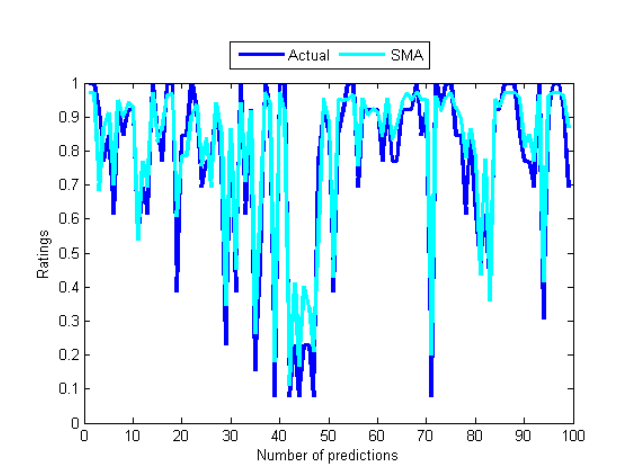
Figure 7. Curves of actual ratings and predicted ratings of